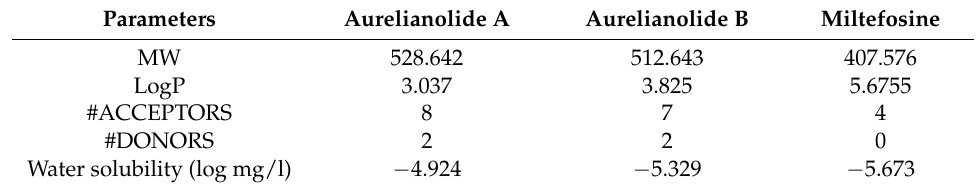
Table 2. Physicochemical parameters and Lipinski’s rule of five of withanolides and miltefosine using pkCMS